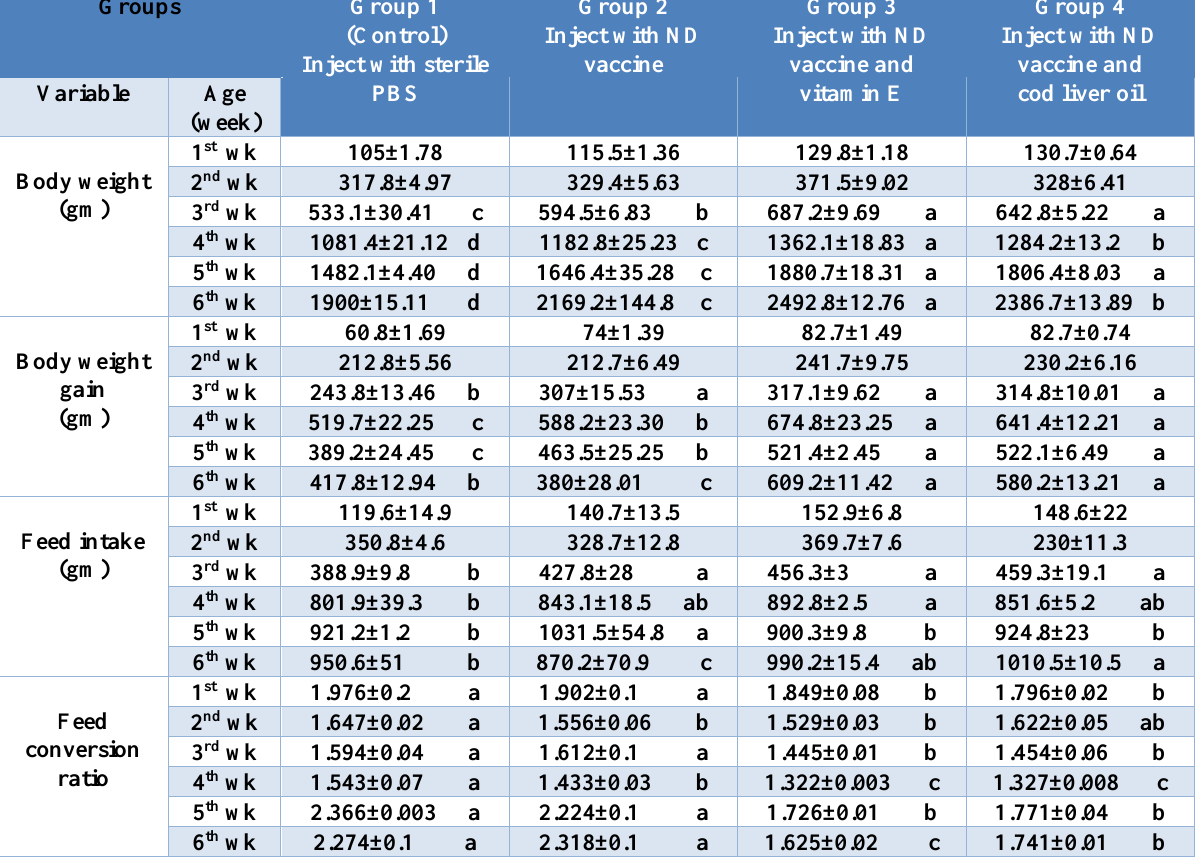
Table, 2: Mean ± Standard Error body weight, body weight gain, feed intake and feed conversion ratio for different groups.